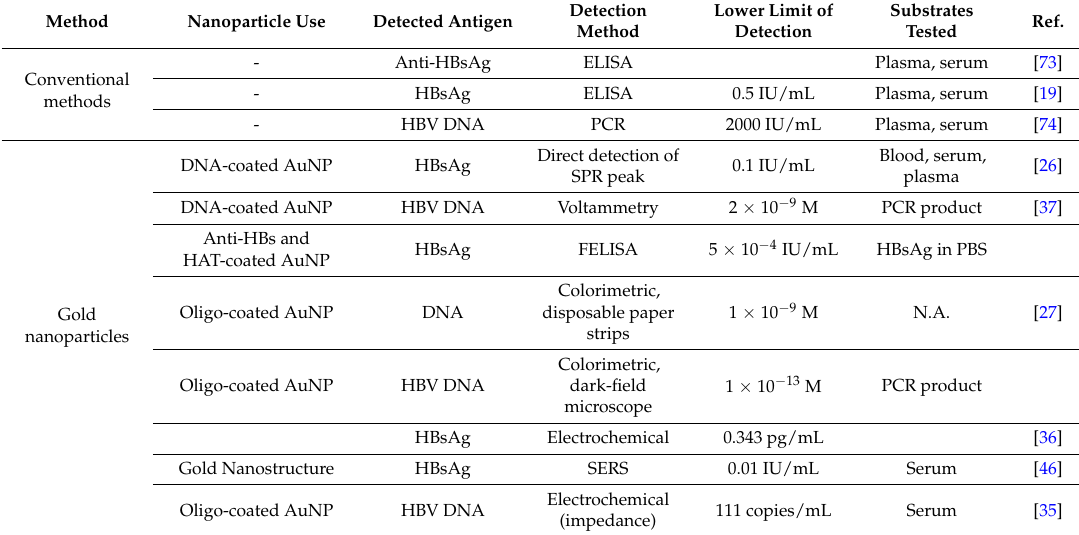
Table 1. Overview of different nanoparticle-based detection methods and their detection